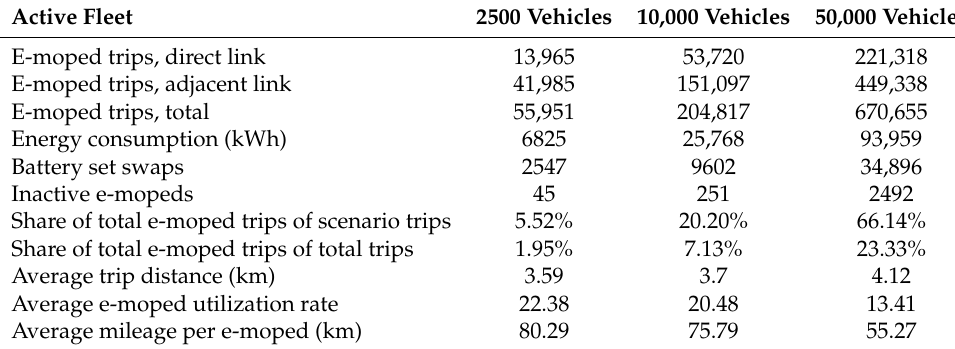
Table 9. Daily sharing simulation results for main scenarios.